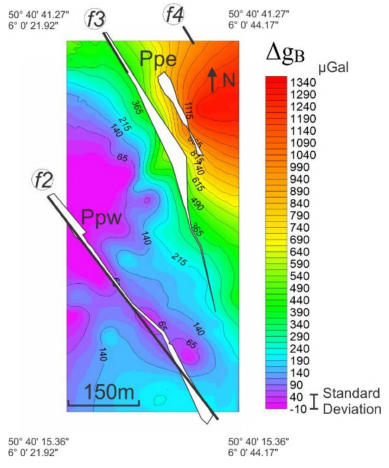
Figure 10. Bouguer anomaly map of the survey area. Gravity data were interpolated using the minimum curvature method with a cell size of 2.5 m 2 . Ppe—Poppelsberg East mineralization; Ppw—Poppelsberg West mineralization. Circled f2, f3, and f4 correspond to extensional faults. First 300 m of gravity Profile 4 have been removed in this map because they correspond to inconstant measures in swamp